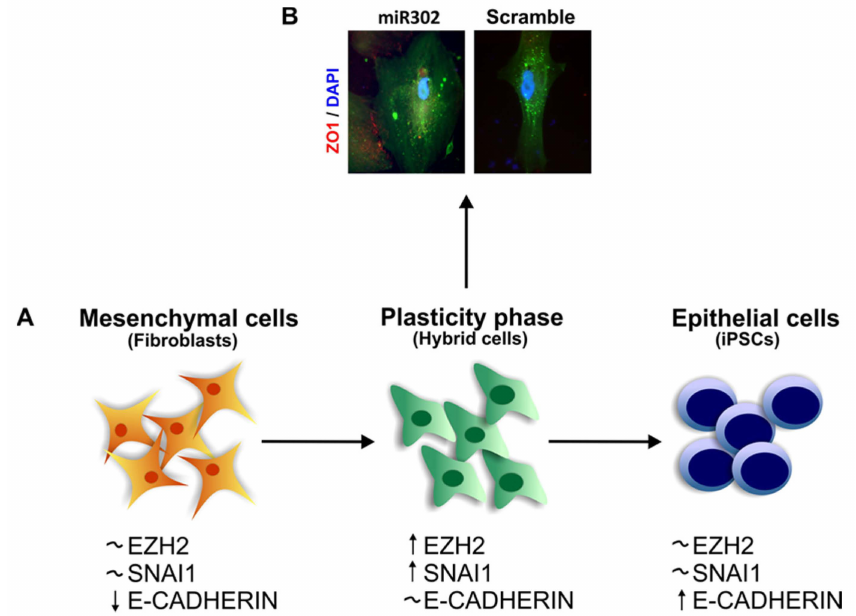
Figure 3. From mesenchymal to epithelial fate: routes to plasticity. Mesenchymal cells are characterized by a fibroblastic spindle-like phenotype. These cells do not express E-Cadherin and they have a low but detectable level of SNAI1 and EZH2. During transition to plasticity caused by forced expression of the 4 Yamanaka factors, these cells undergo a process of profound remodeling and they acquire the expression of both EZH2 and SNAI1. Once they become highly plastic and responsive, at a relatively low ratio, they acquire a fully pluripotent state ( A ). It is interesting to note that a similar process take places when human mesangial cells are forced to acquire a more plastic phenotype. While this process has something in common with fibrosis, the cells do not become fibrotic but they only acquire an enhanced plasticity. At this critical tipping point if these cells are grown in the right environment and with appropriate stimuli, they acquire epithelial characteristics and de novo expression of Zonula Occludens (ZO)-1 ( B ). This process is very dynamic and can be blocked or